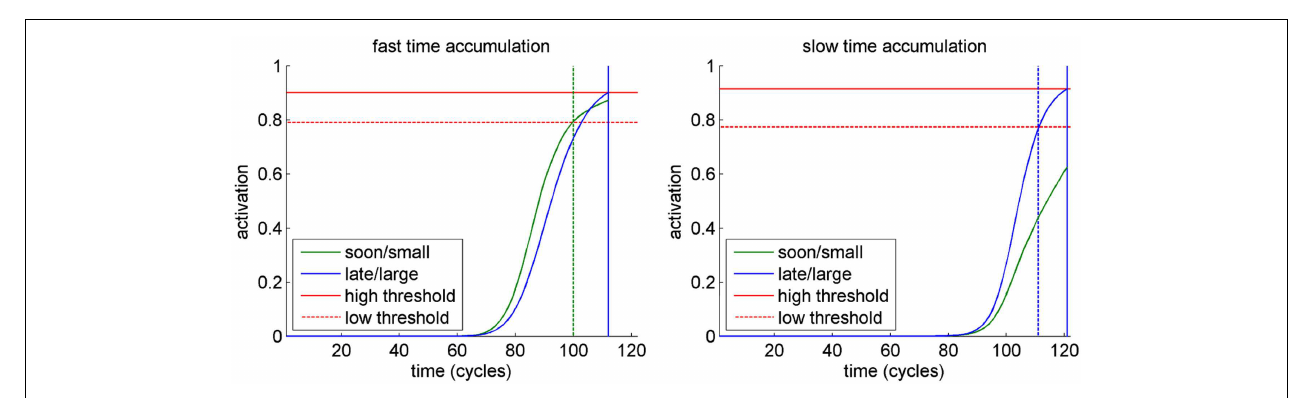
trial. Hence, lowering the threshold changes the final choices (responses indicated by vertical lines). In the slow time accumulation condition (right), there is no difference in choice between the high and the low